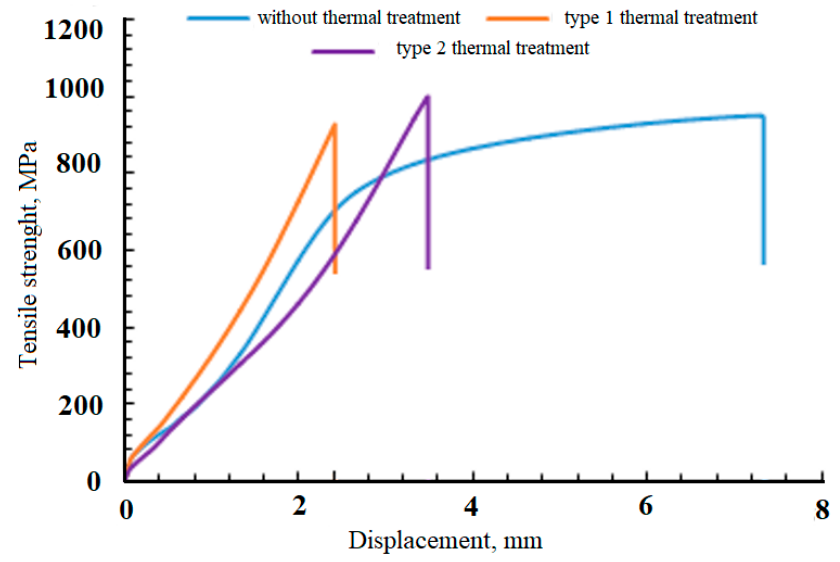
Figure 7. A graph of the dependency of the mechanical strength on the travel distance. ~21% and 12%, respectively. Meanwhile, thermal treatment reduced tensile deformation